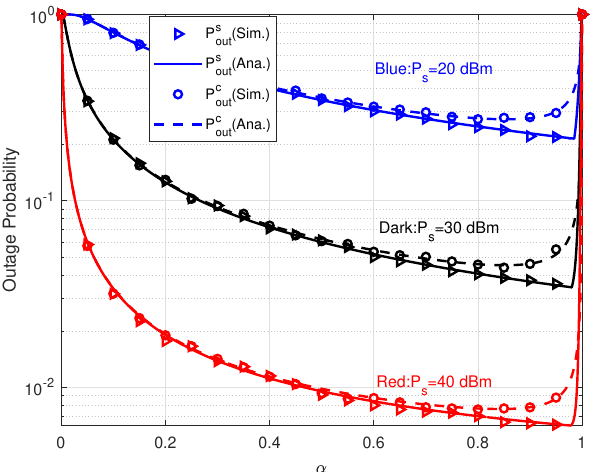
Figure 4. Outage probabilities versus α with different P s